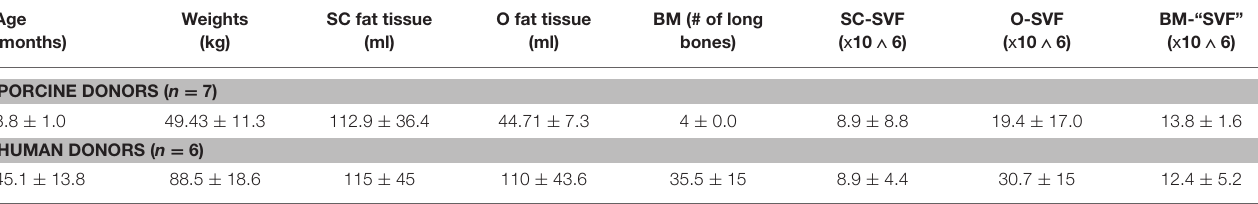
TABLE 1 | Isolation